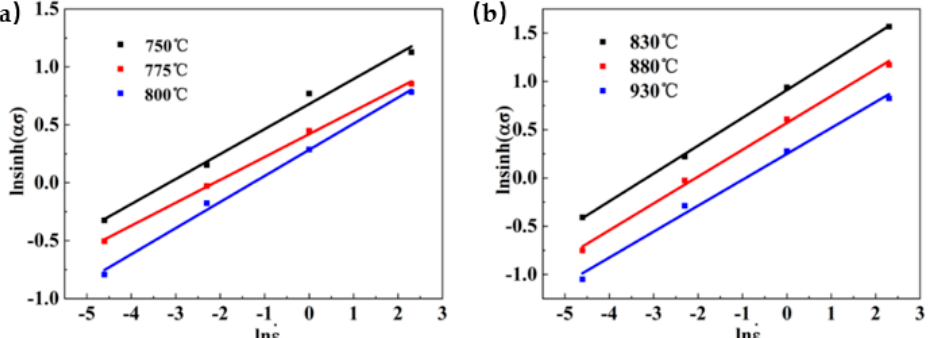
Figure 5. Relationship between ln[sinh ( ασ )] and ln έ at different deformation temperatures : ( a ) α + β region; ( b ) β region.